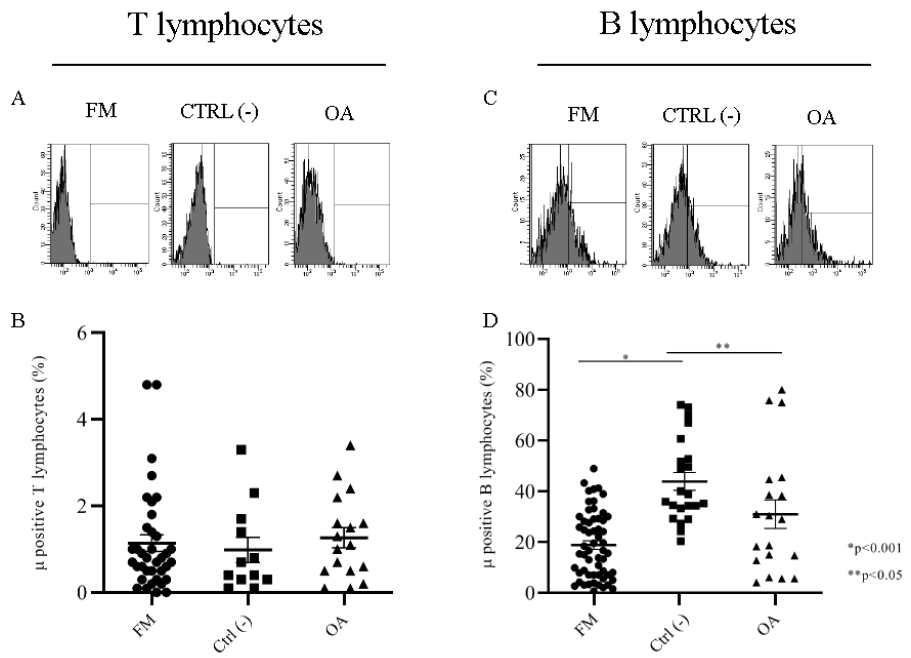
Figure 1. Flow cytometry analysis of the Mu opioid receptor in fibromyalgia (FM), osteoarthritis (OA) and CTRL( − ) patients in T lymphocytes ( A ) and B lymphocytes( C ). Mu + T cells percentage ( B ) and and CTRL(−) patients in T lymphocytes ( A ) and B lymphocytes( C ). Mu+ T cells percentage ( B ) and Mu + B cells percentage ( D ) in FM, OA, CTRL( − ) patient Mu+ B cells percentage ( D ) in FM, OA, CTRL(−) patient groups.